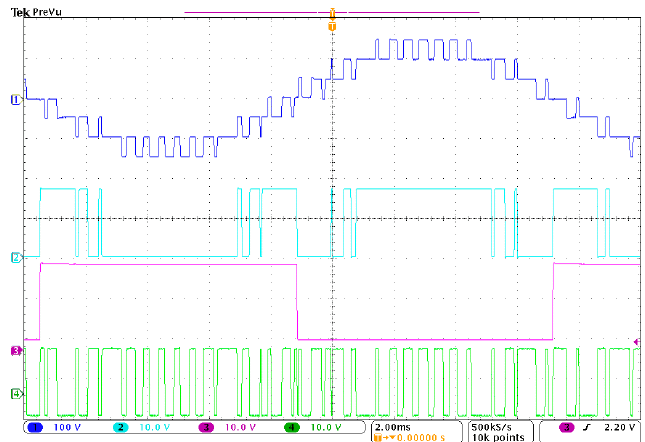
Figure 4. One cycle of output voltage and gate pulses of MPUC inverter switches. Ch 1 : V ab , Ch 2 : T 1 gate pulses, Ch 3 : T 2 gate pulses, Ch 4 : T 3 gate pulses. Table 3. Switching frequency of MPUC inverter switches.